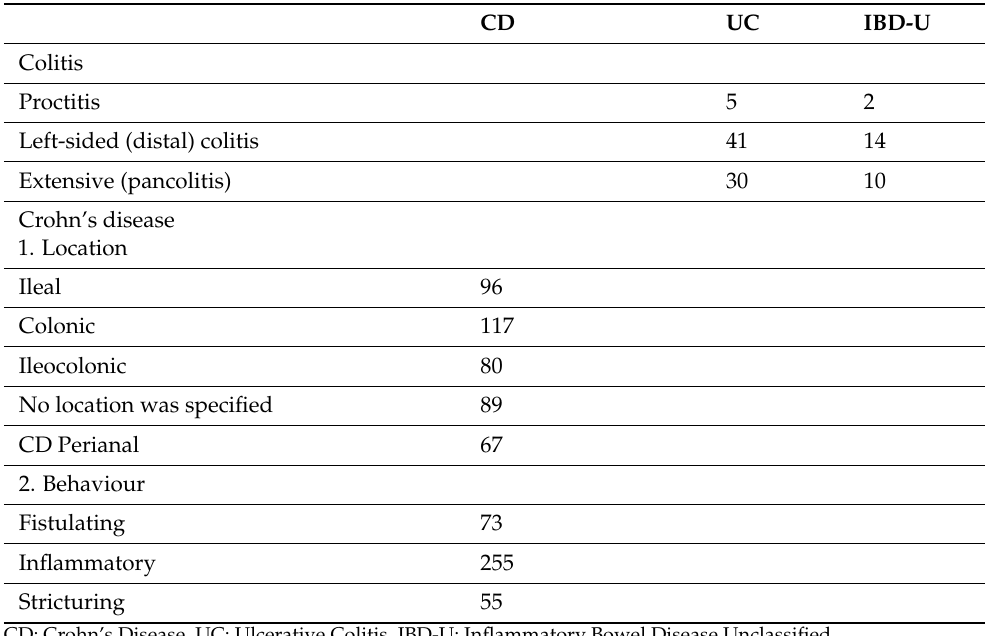
Table 3. The clinical classifications of patients with IBD according to the Montreal classification